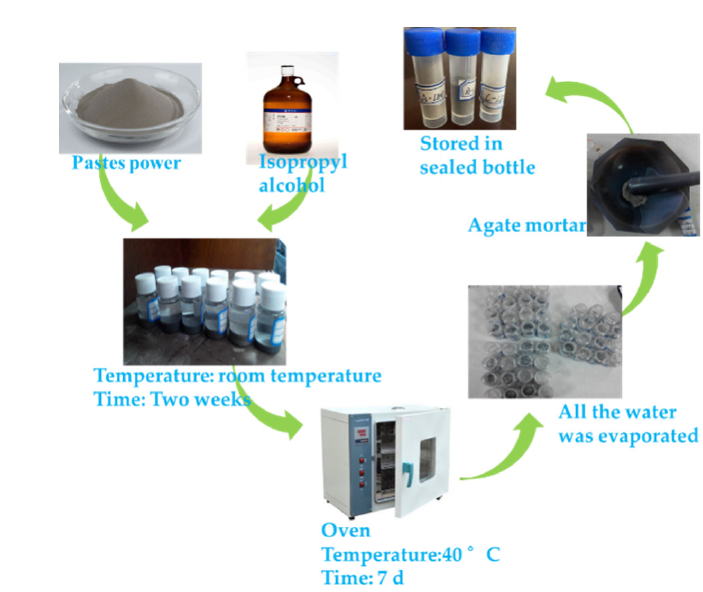
Figure 2. The operation process of samples.